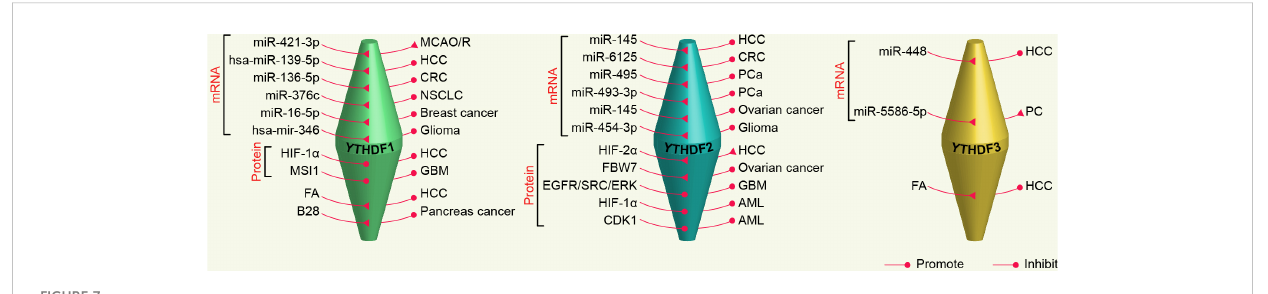
FIGURE 7 The upstream regulations of the YTHDF